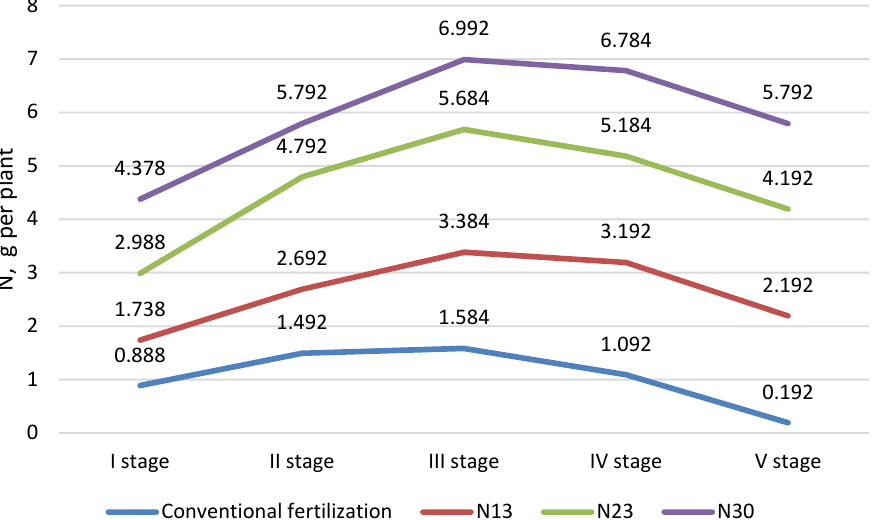
Figure 4. Nitrogen fertilization during the cucumber-growing season (five experimental stages), N13, N23, and N30—additional nitrogen supplementary nitrogen fertilization with nitrogen N13, N23, of N30 on the biometric parameters of cucumber.